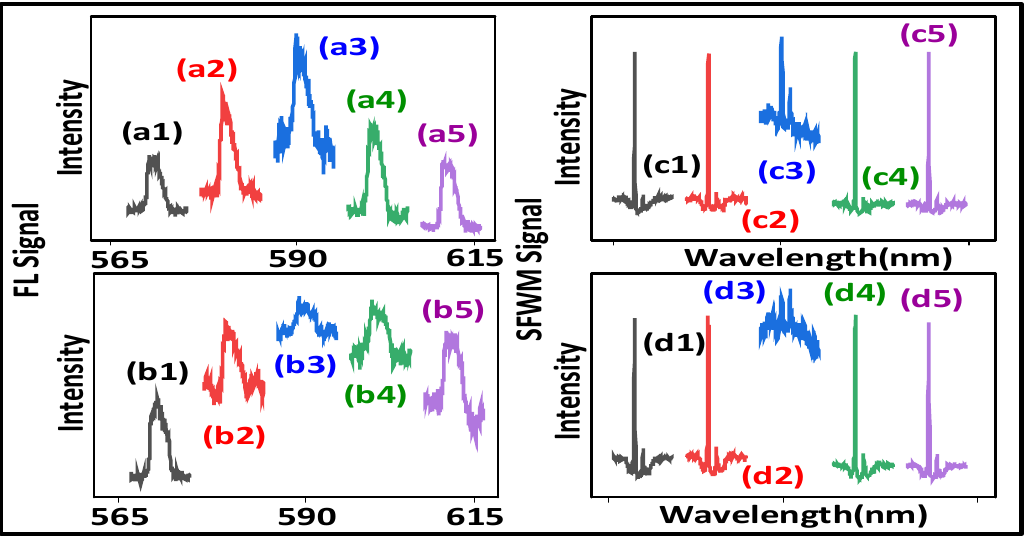
Figure 6. ( a , b ) show FL cross-interaction observed from the output signals of Eu 3+ doped in molar ratio (0.5:1) BiPO 4 at different E 2 wavelengths (567.4 nm, 587.4 nm, 588 nm, 588.4 nm, 602.4 nm) and E 1 scanned from 572.4 nm to 612.4 nm at 300 K, at PMT1 and PMT2, respectively. The time gate is 10 µ s. ( c , d ) show SFWM cross-interaction at 77 K at the time gate = 800 µ s, respectively. The other experimental condition is the same as ( a , b ).